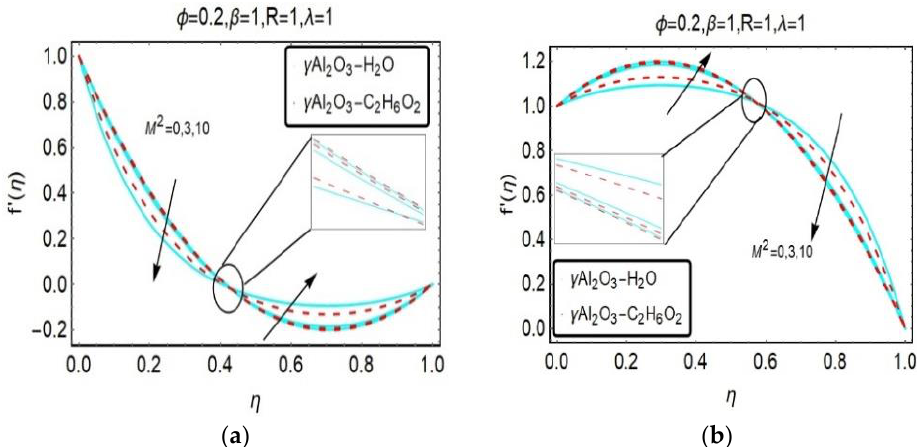
Figure 8. Influence of 𝛽 on 𝑓′(𝜂) for (a) 𝑆 > 0 and (b) 𝑆 < 0 .